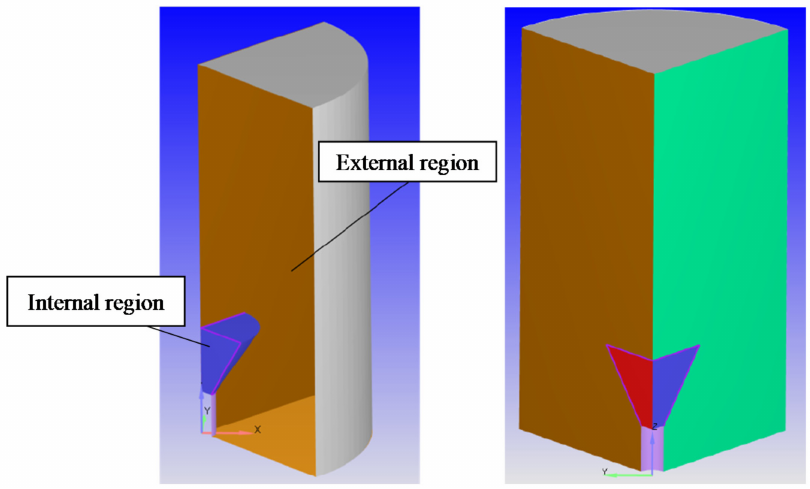
Figure 4. Reactive flow simulations of the computational